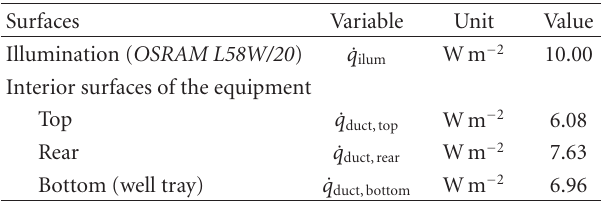
Table 4: Walls heat flux boundary condition.